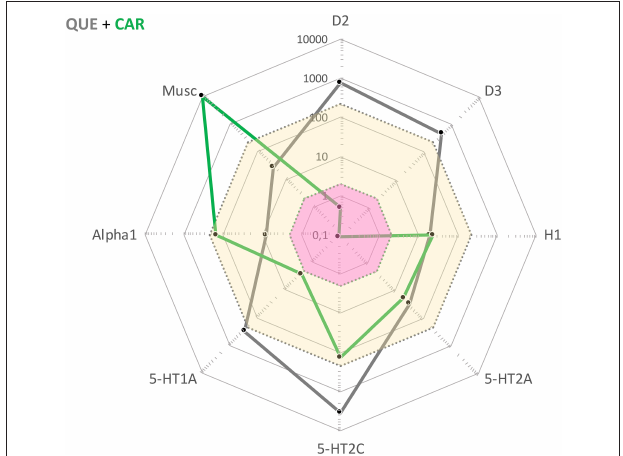
FIGURE 1 | Cobweb depiction of Quetiapine (QUE) and Cariprazine (CAR) target profiles overlaid on the free steady-state plasma concentrations of these antipsychotics at average clinical dosage (QUE: yellow area; CAR: pink area). Black dots correspond to drug affinities reported in the literature (in nM) for the targets labeled on the edges of the cobweb; the closer to the center, the higher affinity for the target in